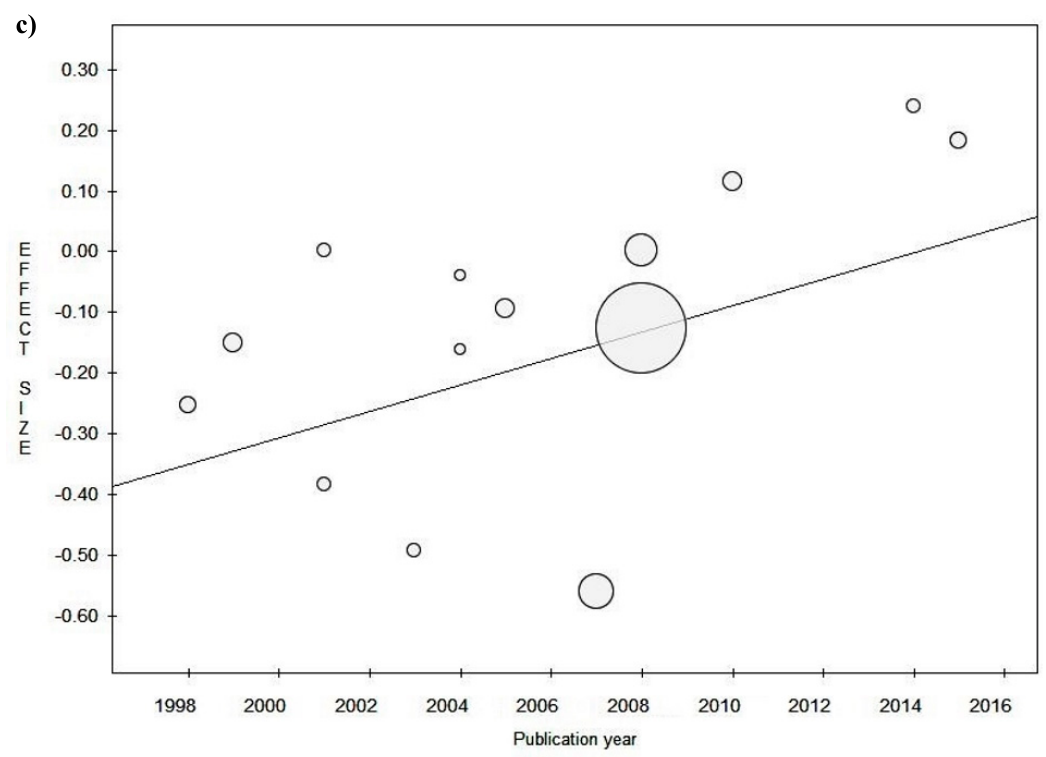
Figure 2. Forest plot ( a ) of the meta-analysis comparing green tea consumption in breast cancer (BC). Funnel plot ( b ). Publication year plot ( c ). Abbreviations: ES = effect size; CI = confidence interval; W = weight; Sig = significance; N = number.